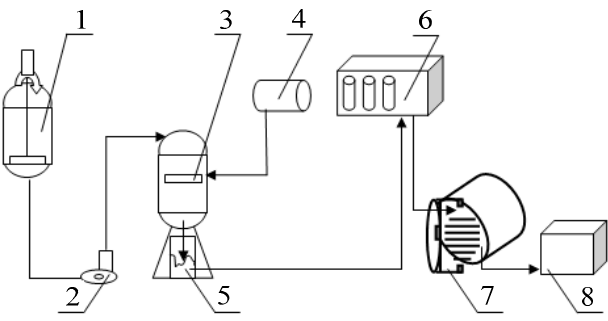
Figure 2. Scheme of the cryochemical vacuum sublimation setup for producing SiO 2 nanopowder: 1—apparatus for the preparation of an aqueous sol; 2—metering pump; 3—cryogranulator; 4—tanker with liquid nitrogen; 5—capacity for storing cryogranules; 6—refrigerator; 7—sublimation apparatus; 8—box for storing nanopowder samples.